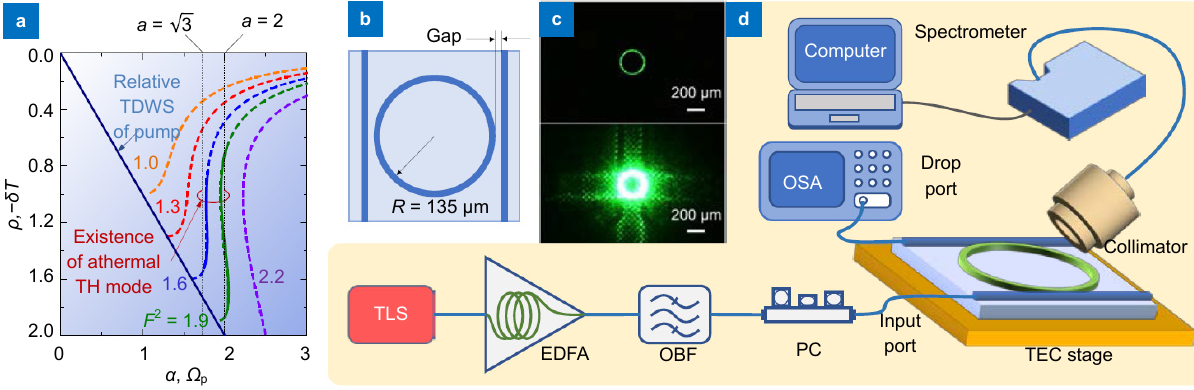
a = 2 a = 3 Fig. 2 | ( a ) The relationship between the normalized pump detuning α and the intra-cavity pump power ρ when the input pump power F 2 is fixed. The existence of stable athermal TH modes were shown in blue ( F 2 = 1.6) and green ( F 2 = 1.9) solid lines when 3 α  . ( b ) Four-port MRR add-drop filter schematic showing a variable bus-ring gap separation design. ( c ) The captured green side-emissions via THG in MRRs at different chip tem- peratures. ( d ) Schematic experimental setup of THG in MRR. TLS: tunable laser source; EDFA: erbium-doped fiber amplifier; OBF: optical bandpass filter; PC: polarization controller; TEC: thermoelectric cooler; OSA: optical spectrum analyzer.